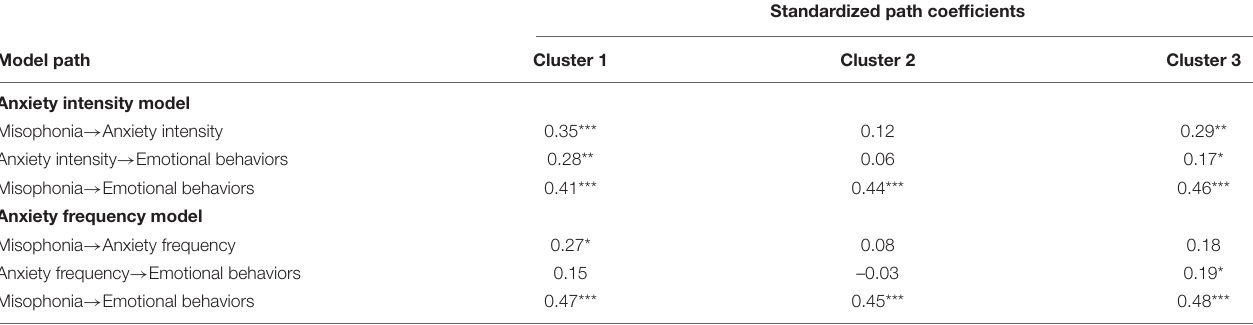
TABLE 8 | Mediation model path